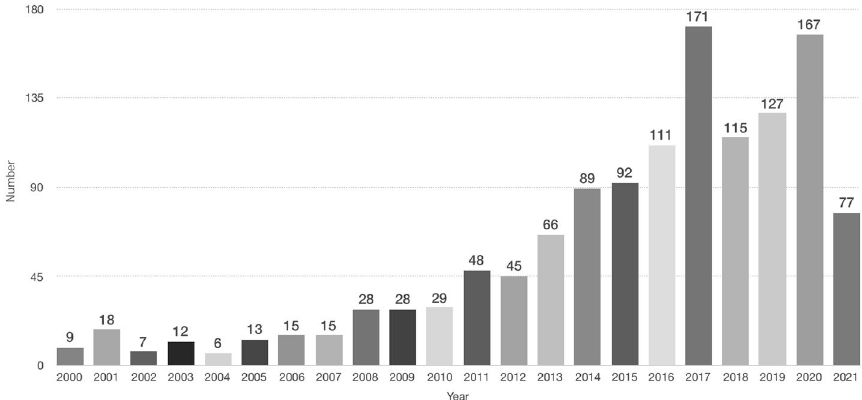
Fig. 1 Total publications and sum of times cited from 2000 to 2021 according to the web of science. Data updated to September